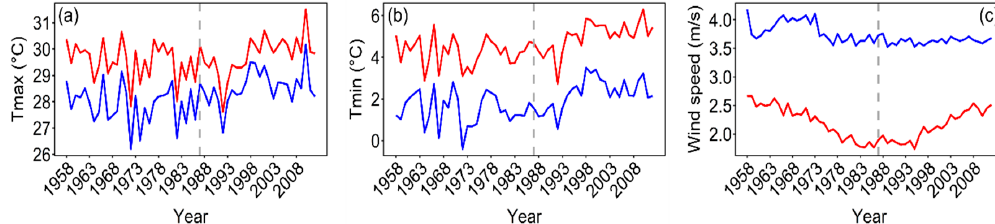
Figure 10. Time series of ( a ) annual average maximum, ( b ) minimum temperatures, and ( c ) wind speed using 37 station data from 1958 to 2012 (legend refers to Figure 6, red line represents observed data at station points, blue line represents original Princeton data at grid cells, and grey dashed line denotes year 1987).